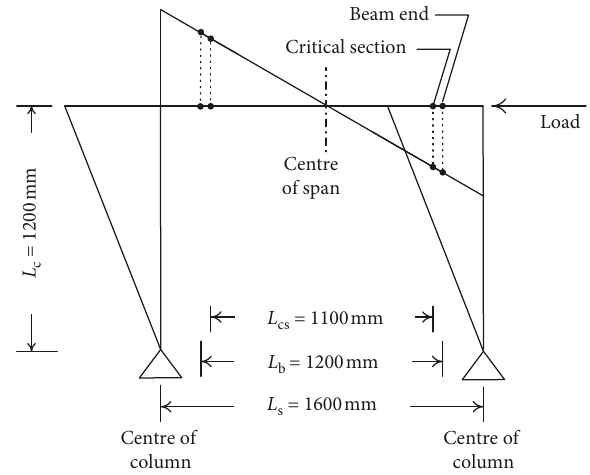
Figure 11: Moment distribution of the frame; adapted from “The Effect of Intermediate Stiffeners on Steel Reinforced Concrete Beam Behaviors”